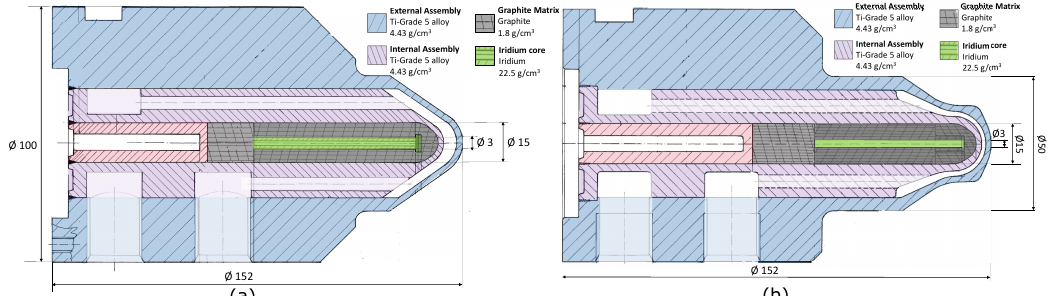
Figure 6. Simplified drawings of two different AD-Target designs inspected by neutron imaging (concept in operation since 1989 to 2018). During operation, intense and short proton pulses (coming from the left) are impacted onto their iridium core. ( a ) Target with non-irradiated core. ( b ) Radioactive target subjected to 10 6 high intensity proton pulses, corresponding to roughly to 2 × 10 18 protons on